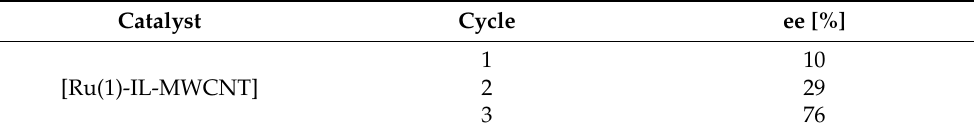
Table 2. Recycling of [Ru(1)-IL-MWCNT] catalysts in the racemization reaction with alcohol 1.